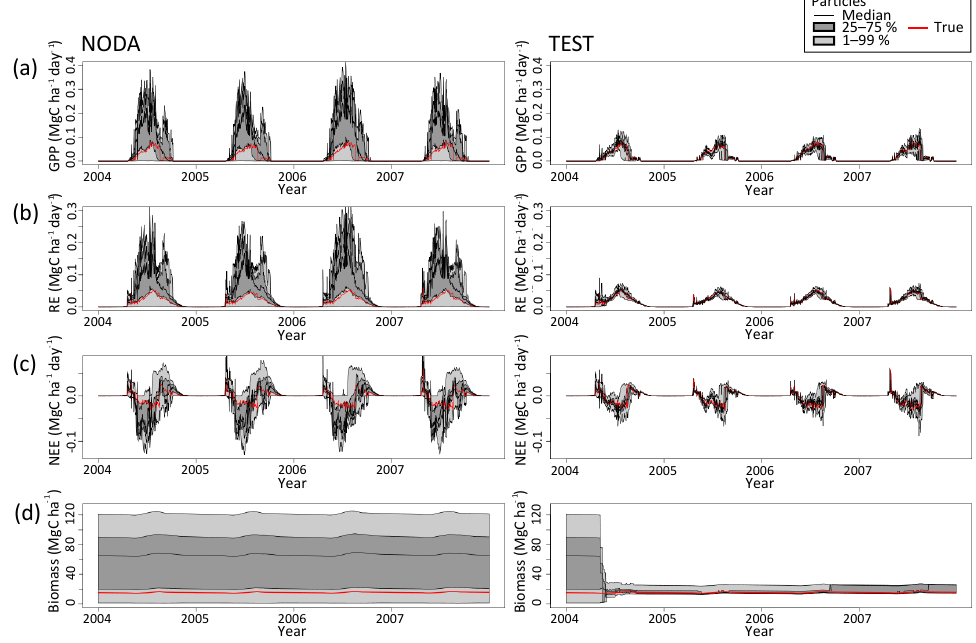
Figure 5. Similar to Figs. 3 and 4 but for unobserved model variables: (a) GPP, (b) RE, (c) NEE, and (d) biomass.